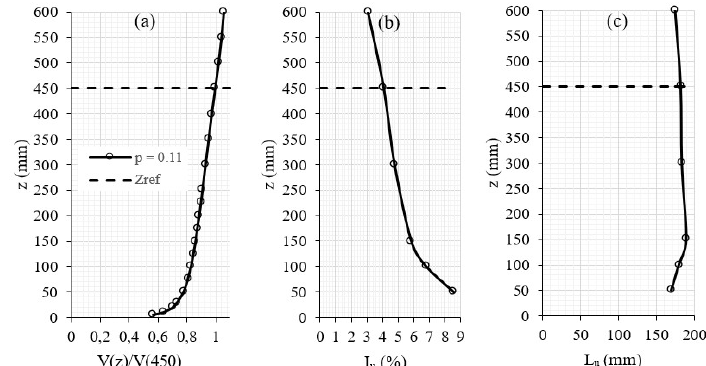
Figure 1. Characteristics of wind in tunnel tests: (a) mean wind speed profile; (b) intensity of the longitudinal turbulence component; and (c) longitudinal turbulence scale.